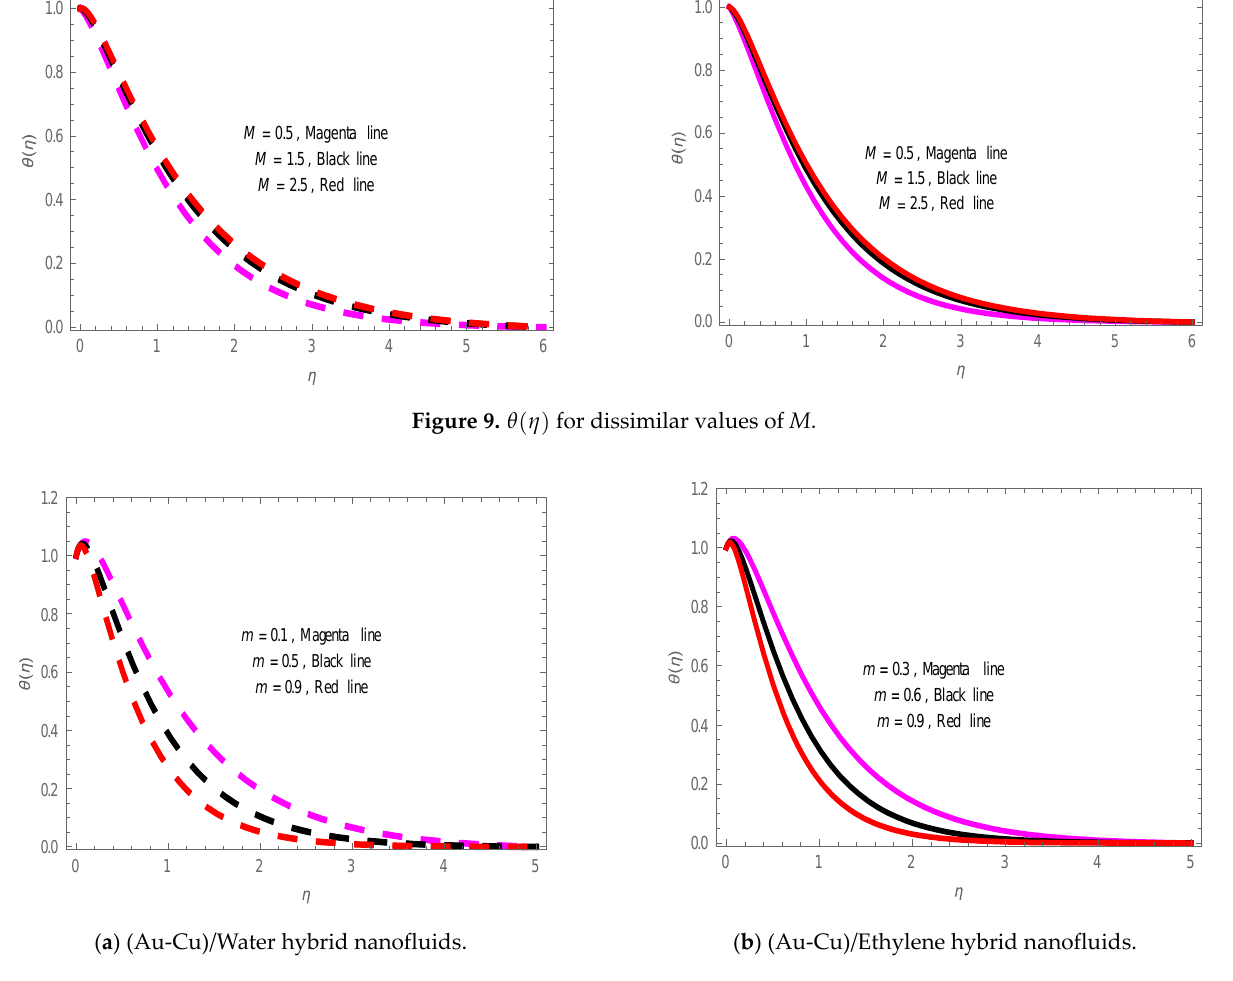
Figure 10. 𝜃(𝜂) for dissimilar values of m. Figure 10. θ ( η ) for dissimilar values of m